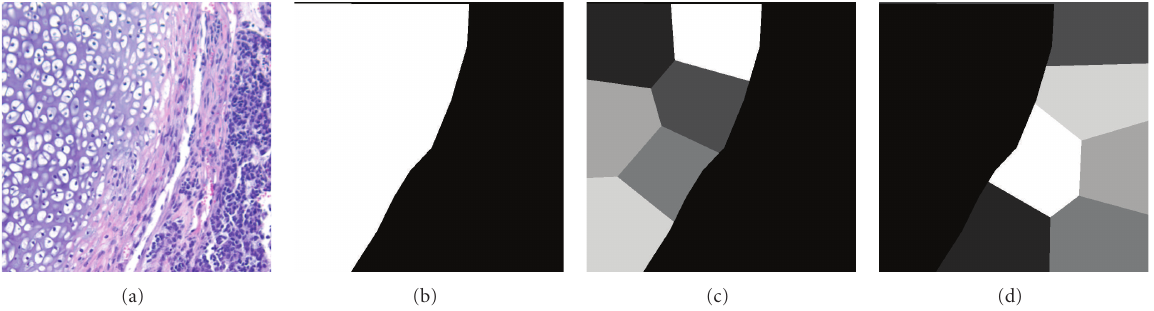
Figure 3: Examples of spatial sample separation. (a) Original image. (b) Ground truth. (c) Spatial sample separation in interested tissue. (d) Spatial sample separation in background/other